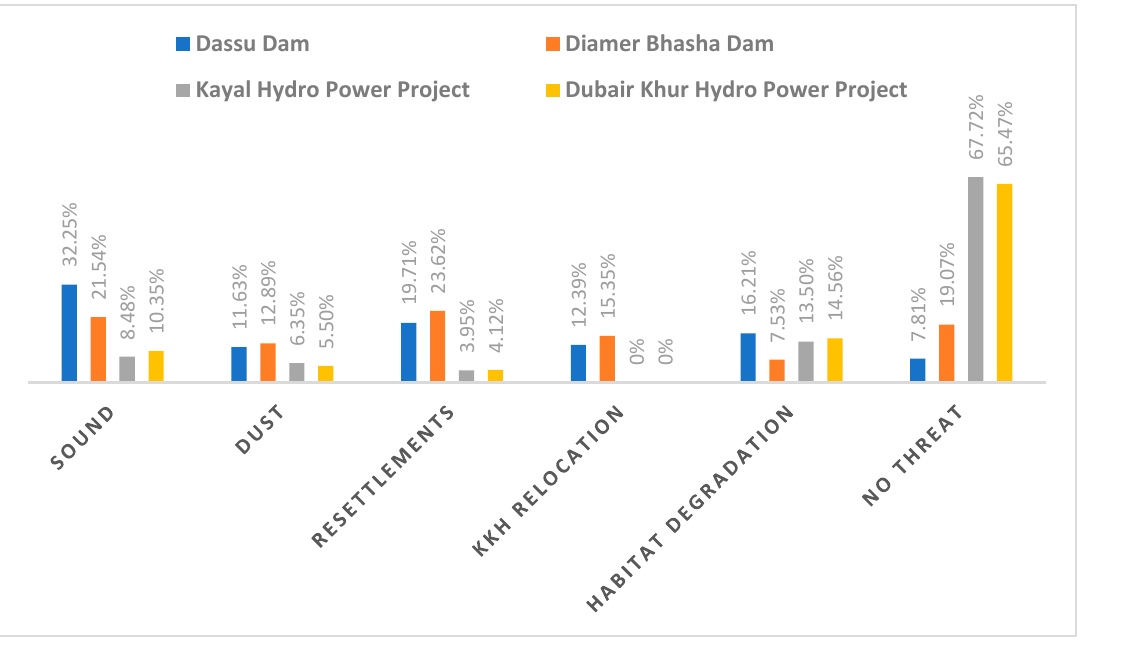
Figure 5. Different newly emerging threats imposed by major infrastructure development projects in the study area.